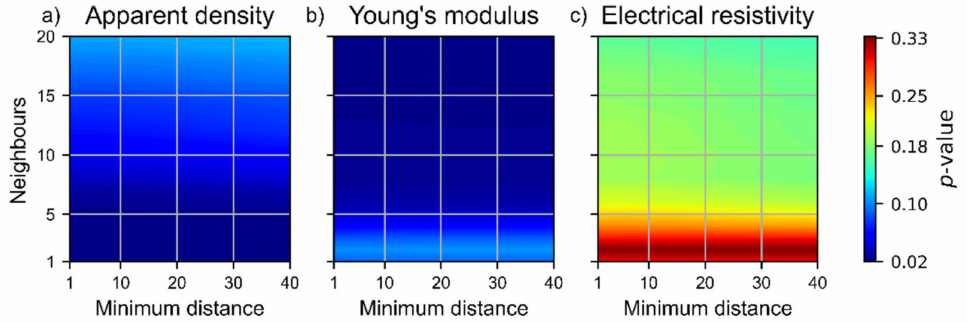
Figure 11. Colormaps for the linear regression slope’s p -value using the average estimate of speed of sound speed in the extracted core samples position for ( a ) Apparent density, ( b ) Young’s Modulus, and ( c ) Electrical